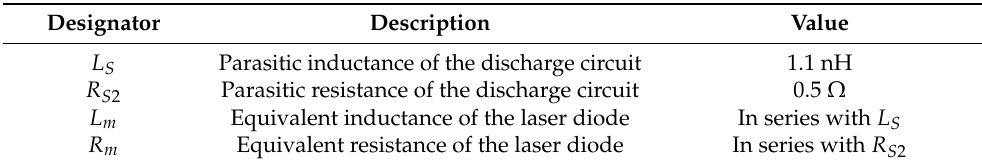
Table 2. Parasitic parameters involved in the simulation.